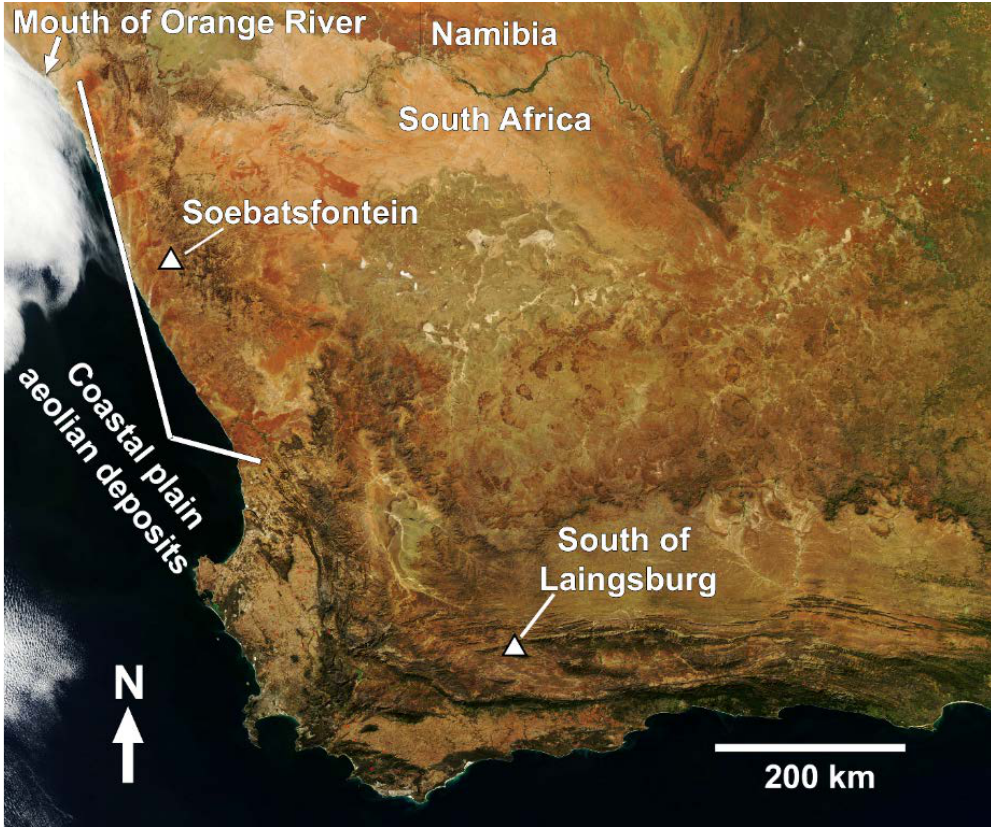
Figure 4. Satellite view of western portion of South Africa (same area as map in Figure 1). The red-hued areas along the coastal plain are old (mainly Pleistocene) dune deposits reddened by pedogenic alteration over time. The Soebatsfontein site is within the area covered to variable extent by those aeolian sand deposits. The South of Laingsburg site, in contrast, is located in an inland, narrow intermontane basin lacking such regionally extensive, fine-grained sediments that can be mobilized by the wind. Sizes of heuweltjies at these two sites and several others were compared in McAuliffe et al. [19].